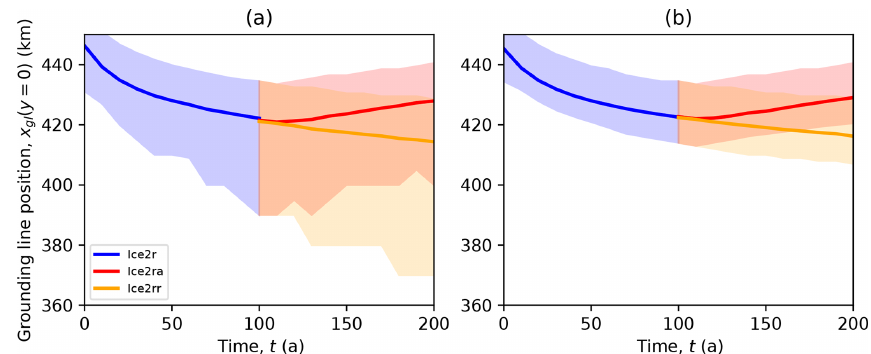
Figure 13. Midchannel grounding line position plotted against time for the Ice2 experiments. Panel (a) shows the mean (solid curves) and the range (shaded regions) over all models. Panel (b) shows the mean (solid curves) and range (shaded regions) for the main subset.